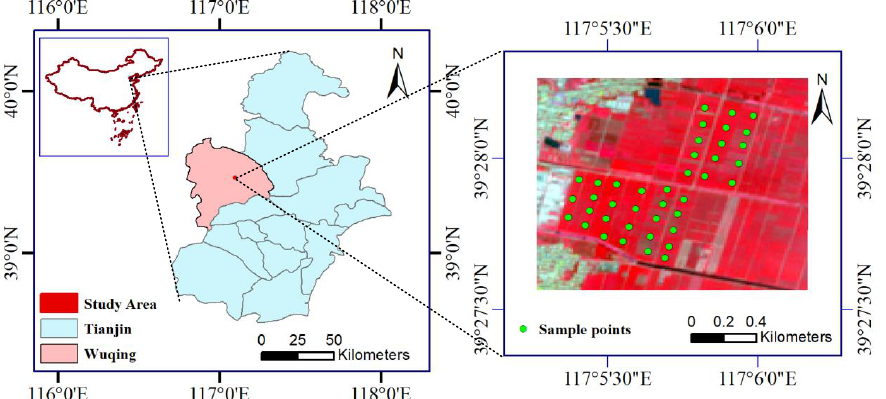
Figure 1. Location of the study area and distribution of sample points.